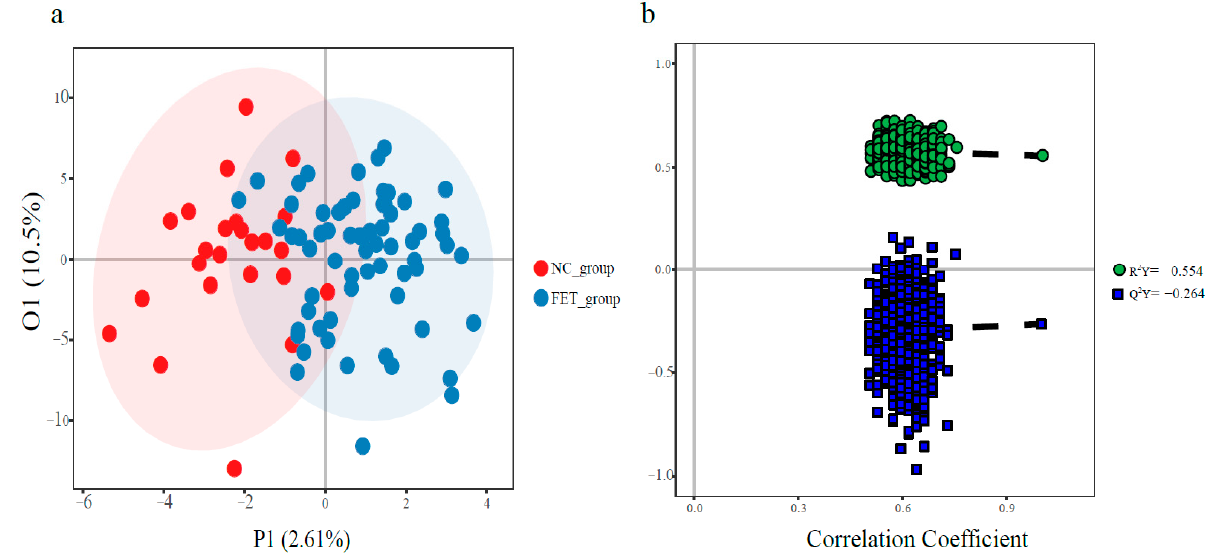
Figure 1 . OPLS-DA score plot and permutation test of the OPLS-DA model ( a ) OPLS-DA score plot, each point represents a metabolic profile of a sample; ( b ) permutation test of the model.